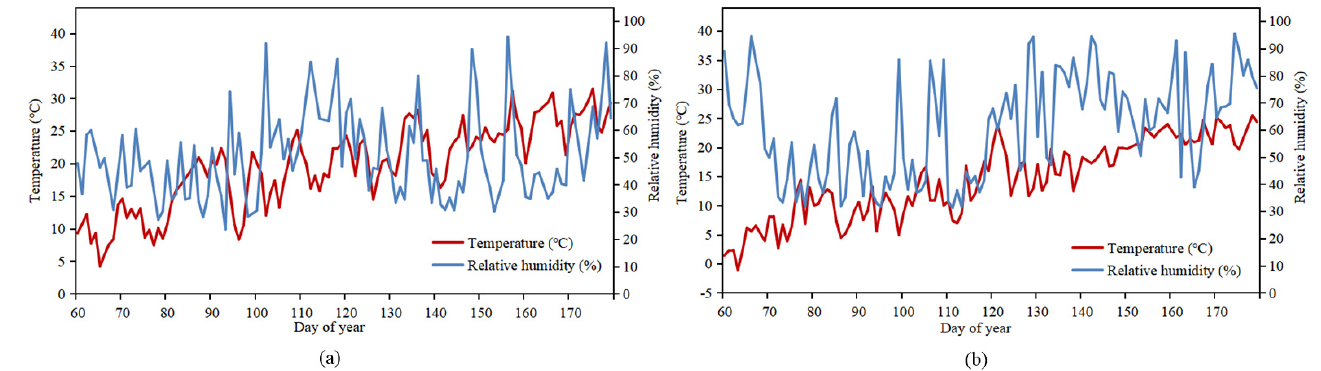
Figure 3. A demonstration of temporal variation of temperature and relative humidity from the 60th to the 170th day in 2020, Linyi County ( a ); and Qixia County ( b ).